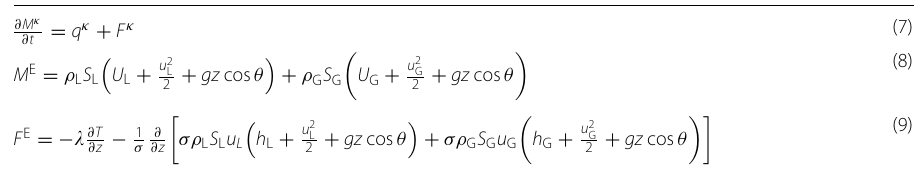
Table 2 Key wellbore